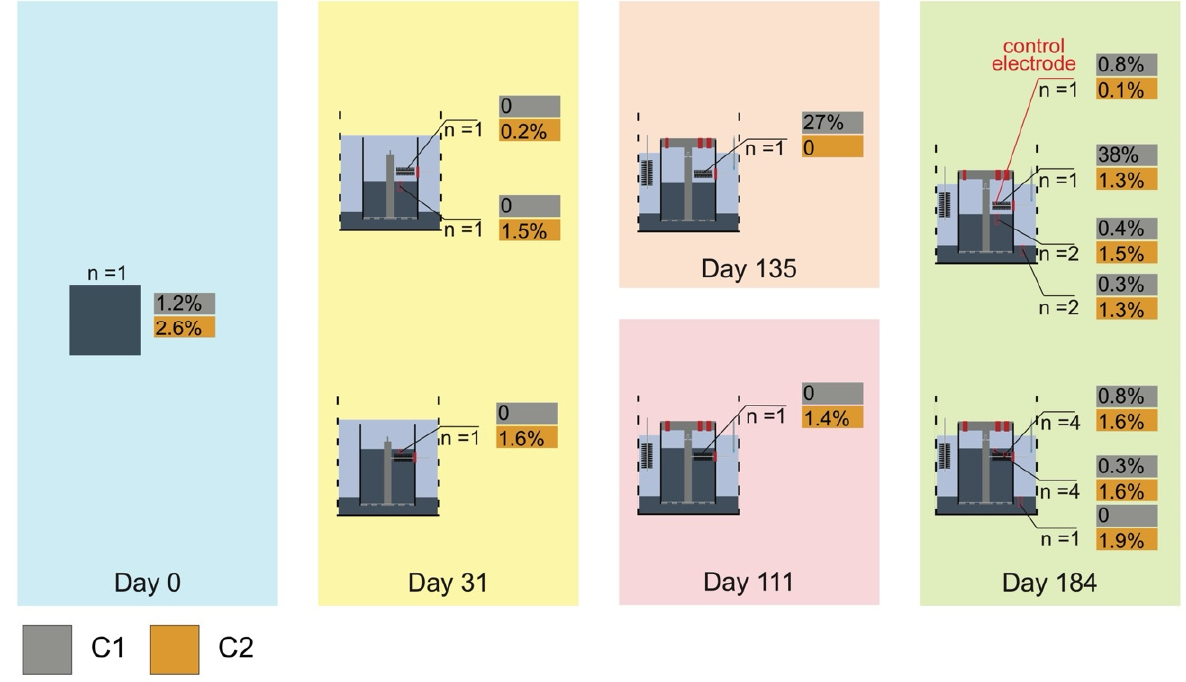
Figure 4. Relative abundance of the two clades of the uncultured Desulfobulbaceae group at different time points of bioelectrochemical reactors operation. Reactor A (RA): the 3 electrodes were hung above the sediment–water interface, displayed in the upper row. Reactor B (RB): the 3 electrodes were set below the sediment–water interface, displayed in the lower row.